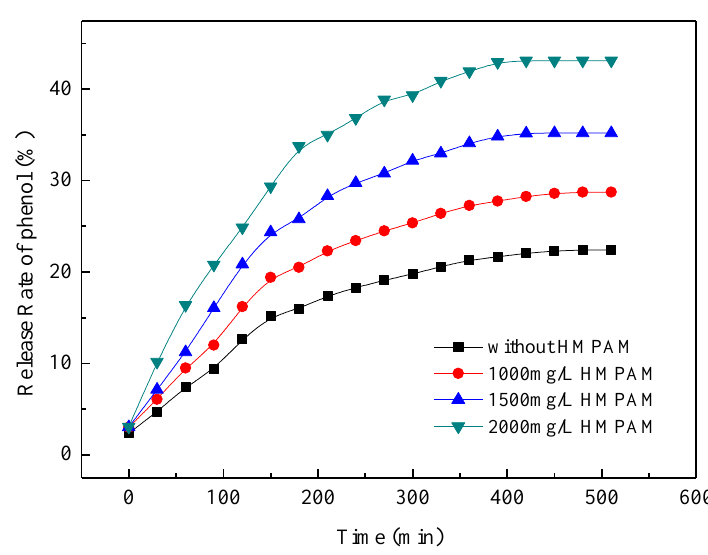
Figure 8. Release rate of phenol from β -cyclodextrin ( β -CD)/phenol inclusion complex at 45 ◦ C. As to the delayed crosslinking amphiphilic polymer gel system based on competitive inclusion method, the probable gelation mechanism can be depicted in Figure 9. Phenol can be controlled released from the cavity of CD in the presence of amphiphilic polymer and formaldehyde can be released from methenamine as shown in Figure 9a,b, respectively; then, acrylamide groups in HMPAM and phenol-formaldehyde can react to form gel [41], as shown in Figure 9c.